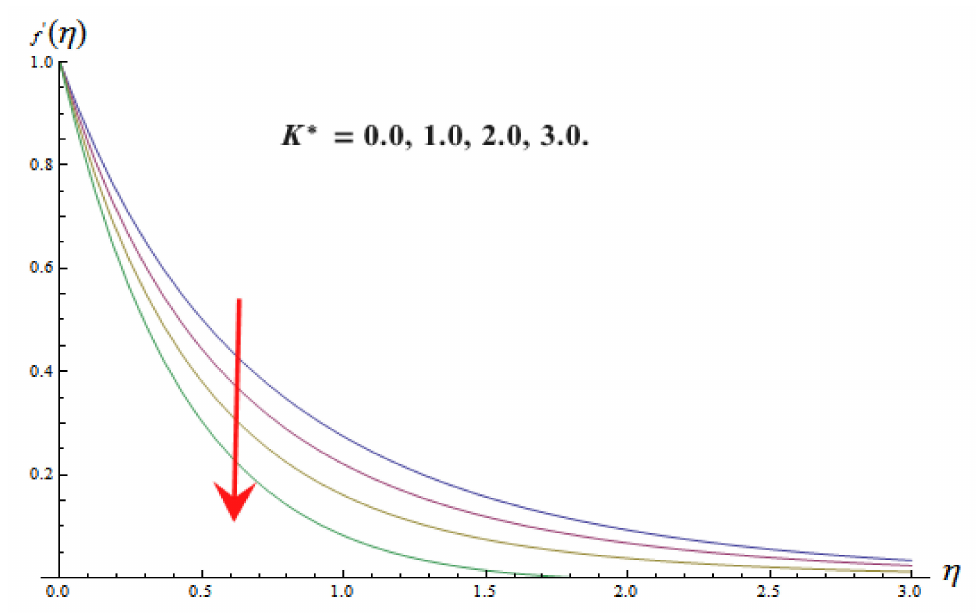
Figure 3. Impact of K ∗ on f (cid:48) ( η ) keeping λ 1 = 2, Pr = 2, Br = 2, λ = 2, Ec = 0.2, Rd = 2, β 1 = 0.2, Ha = 2, K ∗ = 2.